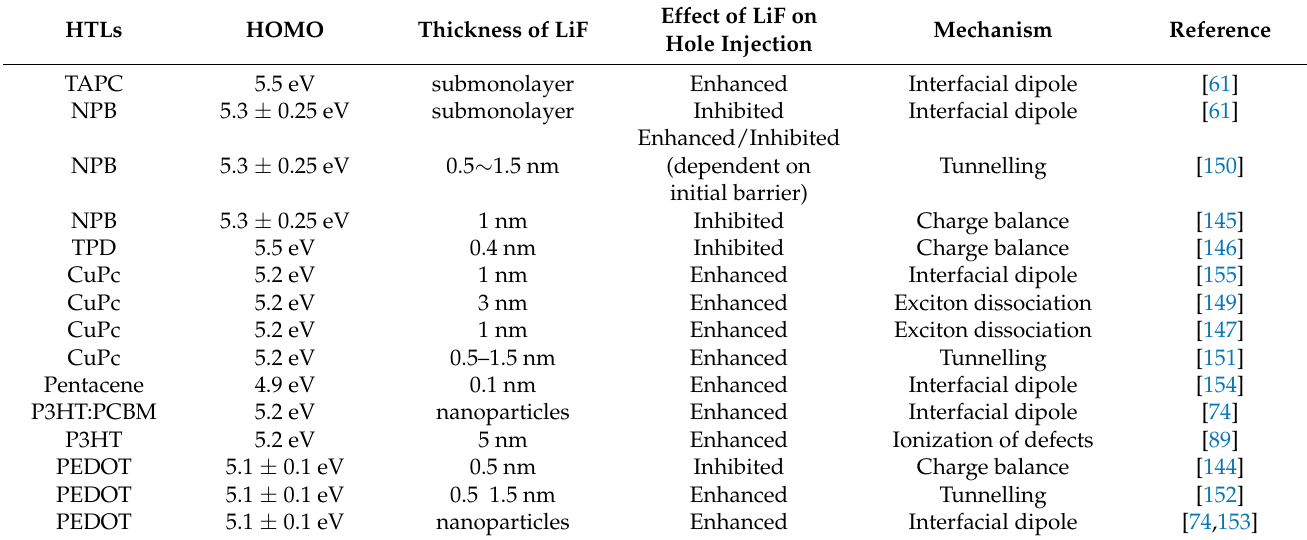
Table 3. Comparison of LiF interlayer effects at ITO surfaces. Reprinted with permission from Springer Nature [61] Copyright